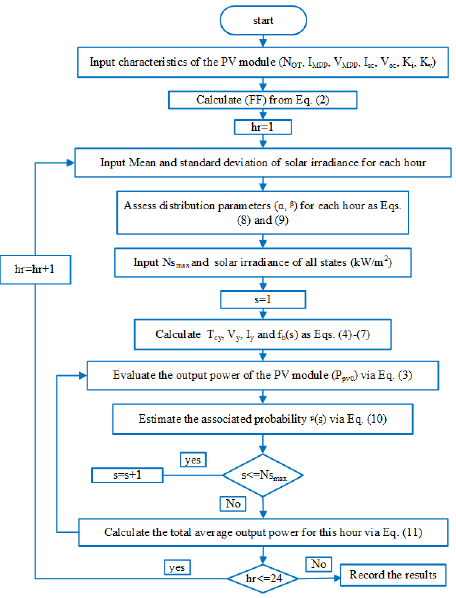
Figure 1. Evaluation of PV output power considering the uncertainties in solar irradiance.